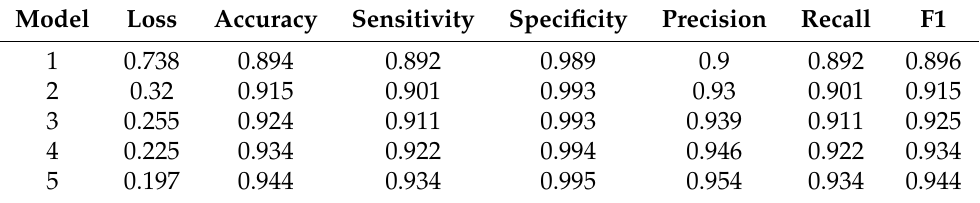
Table 6. Detailed classification performance based on Bayesian optimization and ensemble learning.